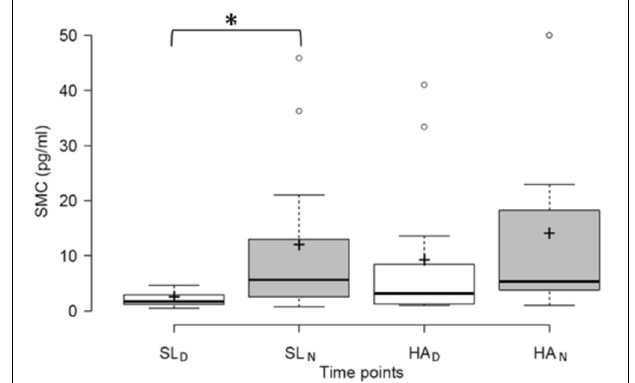
FIGURE 1 | SMC at SL D , SL N , HA D , and HA N . Subindices D and N, respectively, indicate whether the samples were obtained at day or at night. The black line in the boxes denotes the median. Mean values are represented by a cross. White circles indicate outlier values. Asterisks denote that differences are significant ( p <